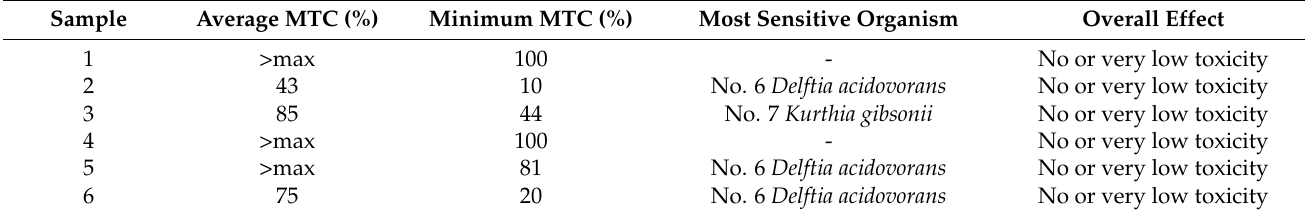
Table 2. MARA test results summary.